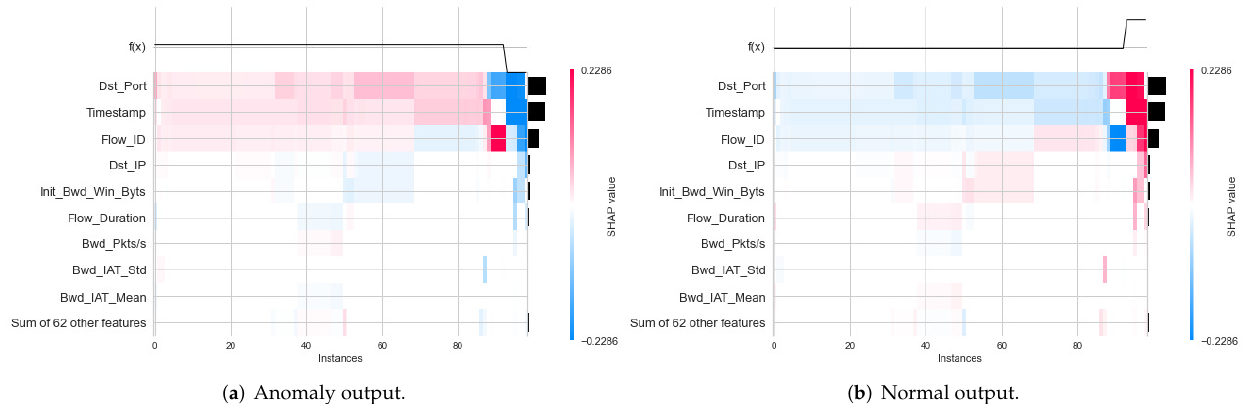
Figure 10. Heatmap curve results of global explanation for IoTID20 dataset in two Label output values: ( a ) 0—anomaly and ( b )